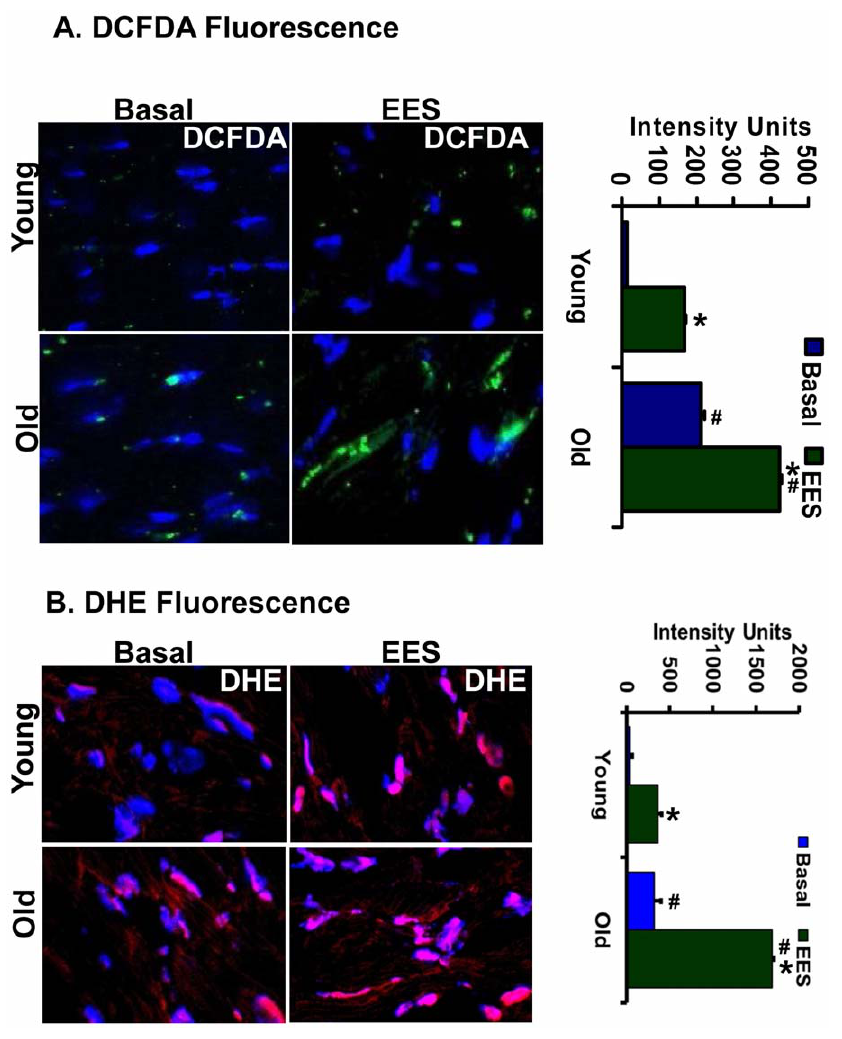
Figure 3. DCFDA/DHE-fluorescence in young and old mice. Myocardial tissue sections (5 m m-thick) on slides were treated with cell-permeable fluorescent H 2 DCFDA (A) and DHE (B). The microscopic images were obtained at a magnification of 60X. The oxidized, fluorescent 2-hydroxyethidium and DCF was imaged using confocal microscopy and quantified using Simple PCI 6 Imaging Software. Increased superoxide and hydrogen peroxides were observed in old heart tissues under basal and EES conditions. Green-DCF, Red-DHE and Blue-DAPI (nucleus stain). Respective intensity calculations were shown in the bar-graphs. *p , 0.001- between basal and EES; # p , 0.001- between young and old.